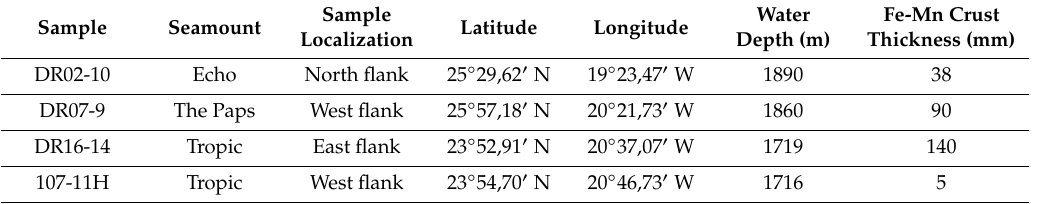
Table 1. Sample localization in the seamount, water depth and Fe-Mn crust